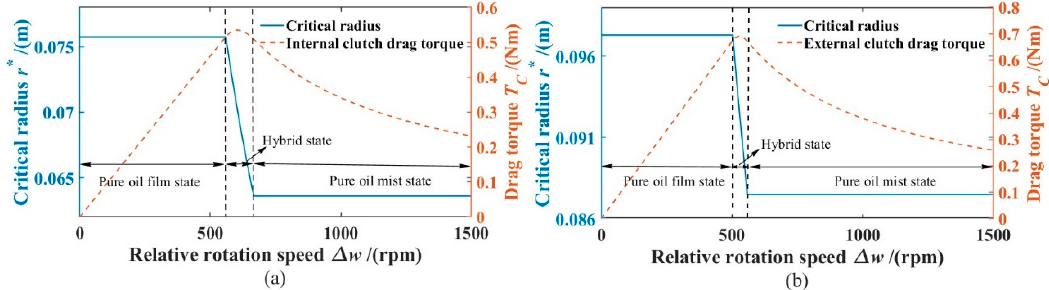
Figure 6. Clutch disc drag torque: (a) Internal clutch; (b) External clutch